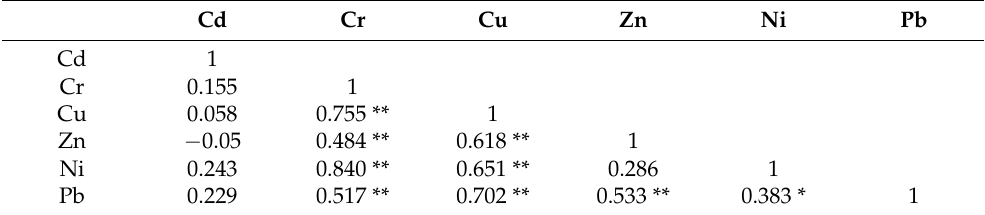
Table 2. Pearson correlation coefficients for soil heavy